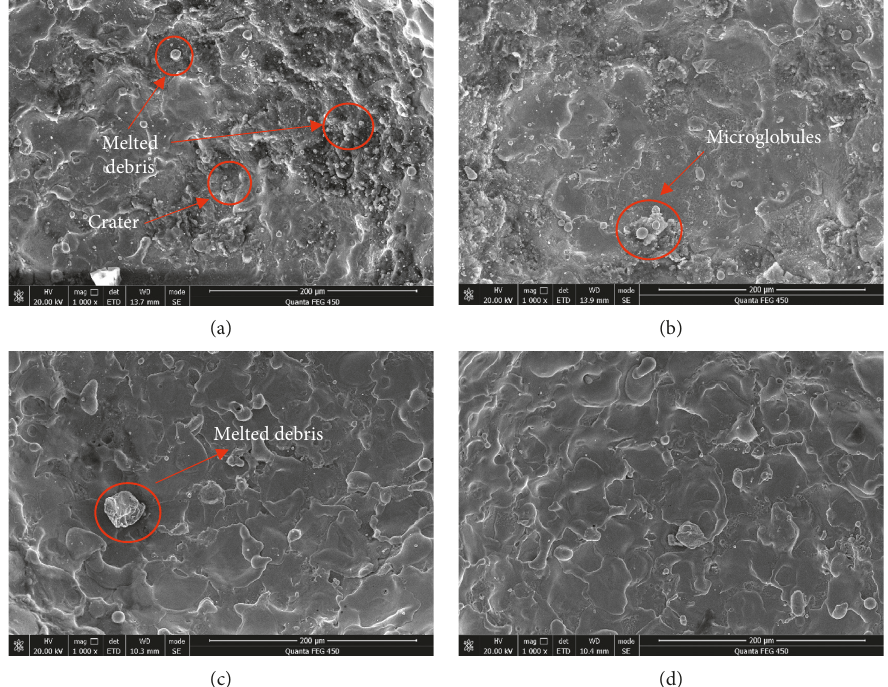
Figure 13: SEM graph of EDM machined surface at: (a) EDM oil; (b) EDM oil mixed with 5g/L Al; (c) EDM oil mixed with 10 g/L Al; (d) EDM oil mixed with 15g/L